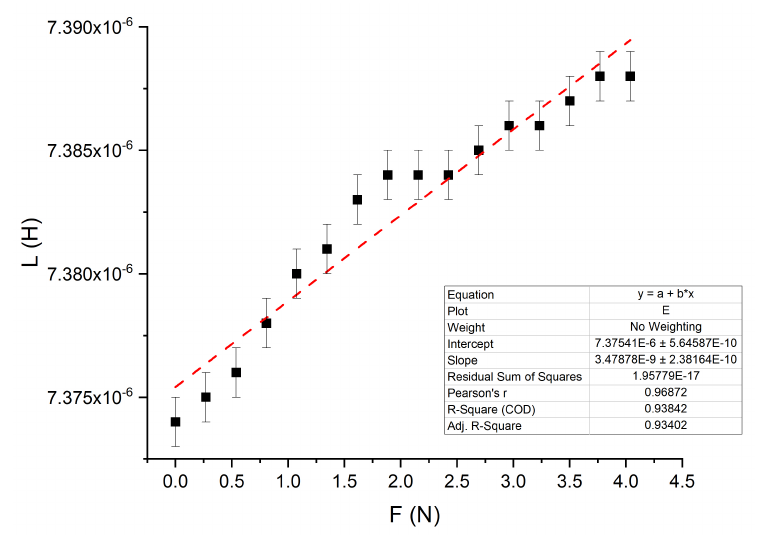
Figure 11. Inductance versus applied force on L1. Broken line is a linear approximation with the parameters shown in the inset.